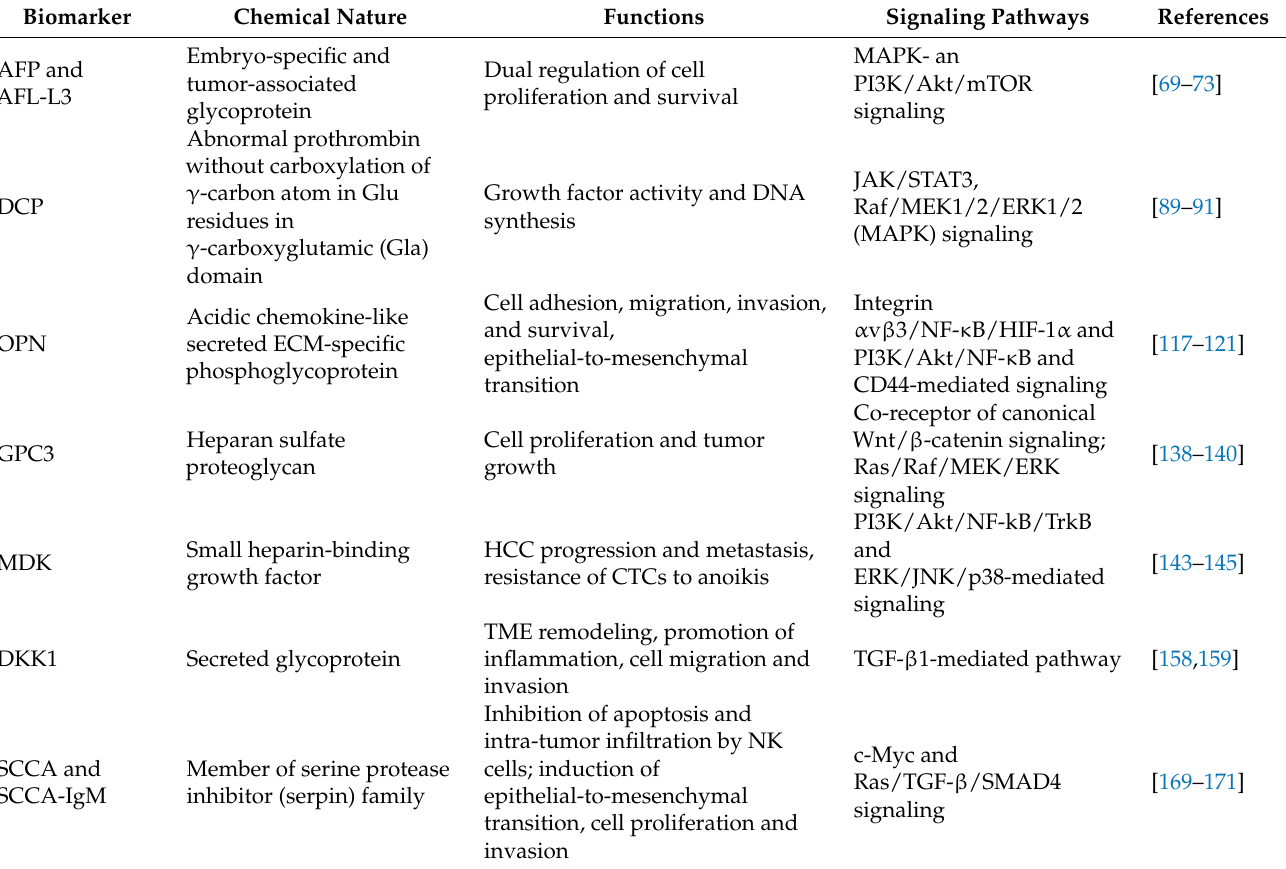
Table 1. Conventional and Promising Circulating Proteomic Biomarkers of